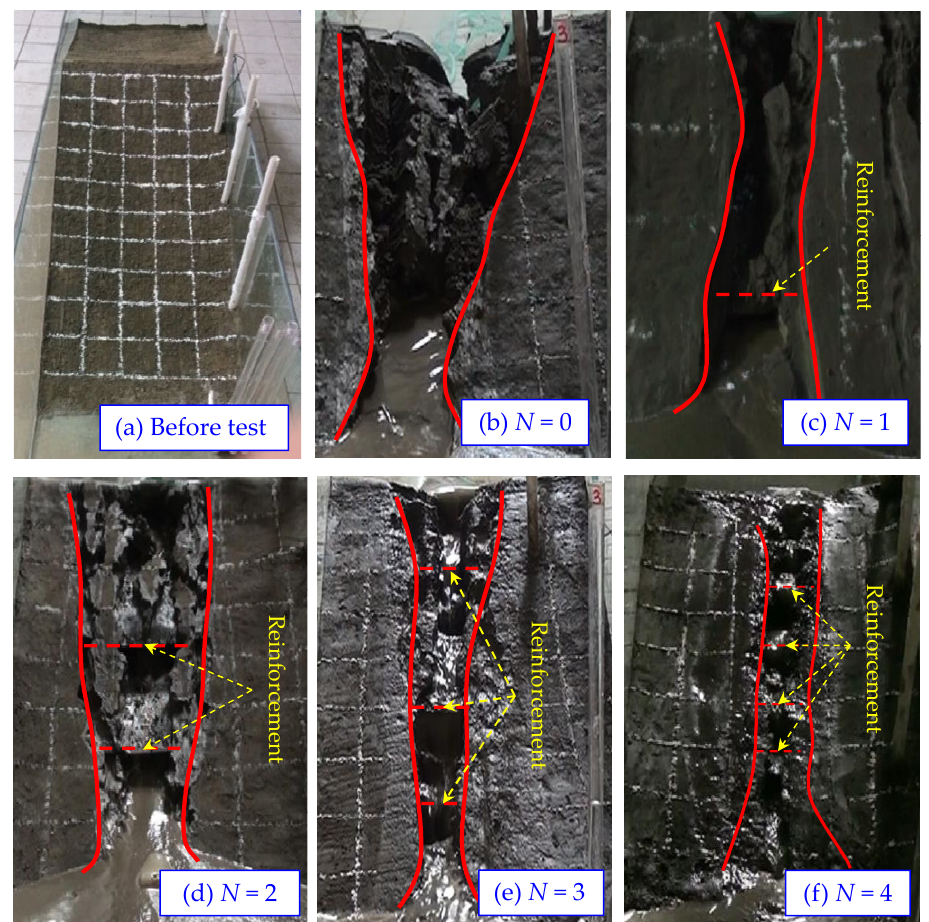
Figure 10. The breach shape for different reinforcement layers. ( a ) Before test; ( b ) N = 0; ( c ) N = 1; ( d ) N = 2; ( e ) N = 3; ( f ) N = 4.